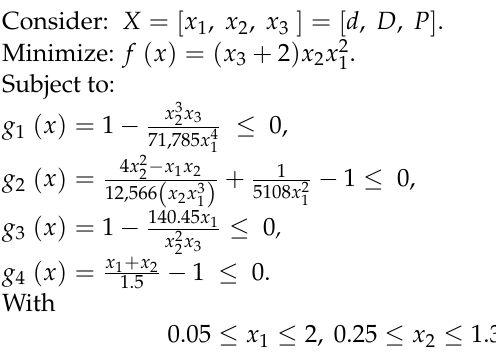
Figure 14. Schematic of the tension/compression spring design.